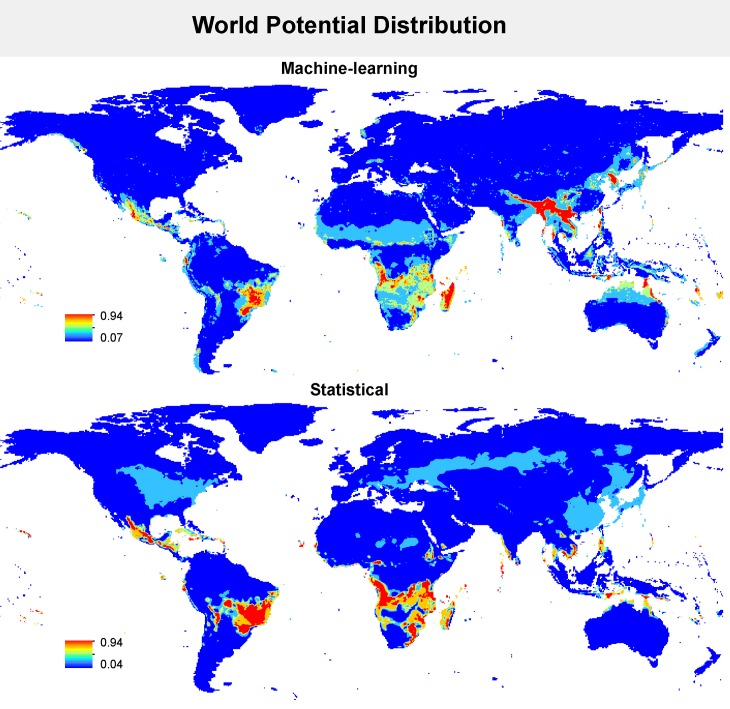
Current projection for dry root rot distribution in common beans in the world according to statistical and machining-learning methods.The model performed in Brazil was used to predict the dry root rot distribution in different places in which the host crop is grown, such as Central America, North of USA, Europe, Africa, and Asia. The legend shows the climatic suitability: 1 is the most adequate, and 0 is the least suitable.